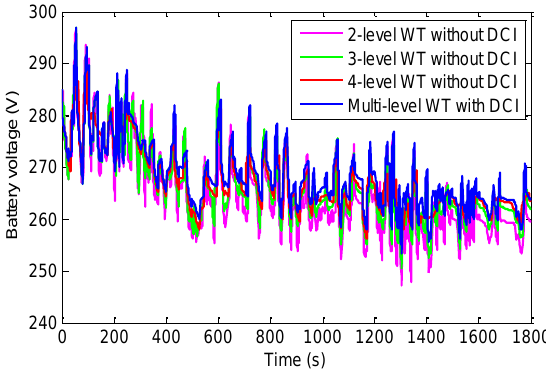
Figure 25. Voltage comparison of battery bank. WT, wavelet transform; DCI, driving cycle identification. Figure 26. Current comparison of battery bank. WT, wavelet transform; DCI, driving cycle identification.